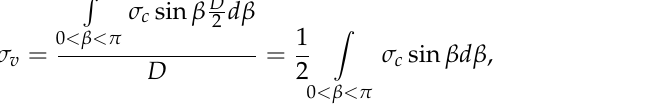
Figure 11. Average vertical pressure on the tunnel lining as a function of computational time. 3.4. Microscopic Characteristics of Ground Response Figure 12 illustrates the particles’ rotational displacements after the tunnel excava- tion, where the positive value represents the counterclockwise angle and vice versa. The figure showed that most of the particles with large rotation angle were concentrated near the top of the excavated tunnel. The farther away from the tunnel, the smaller the rotation